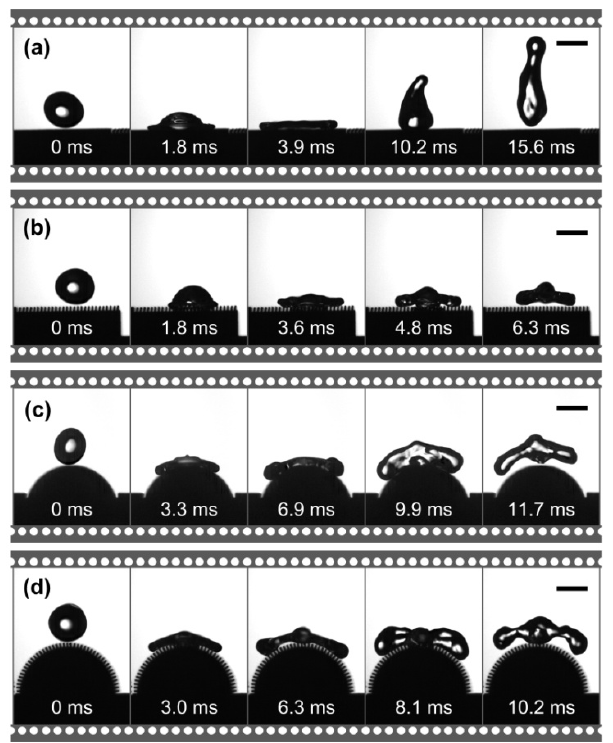
Figure 8. The bouncing process of a water droplet on different aluminum alloy surfaces: ( a ) A dual-level structured plane surface; ( b ) a three-level structured plane surface; ( c ) a dual-level structured convex surface; ( d ) a three-level structured convex surface. All the bars and Weber numbers are 3 mm and 15.2, respectively.